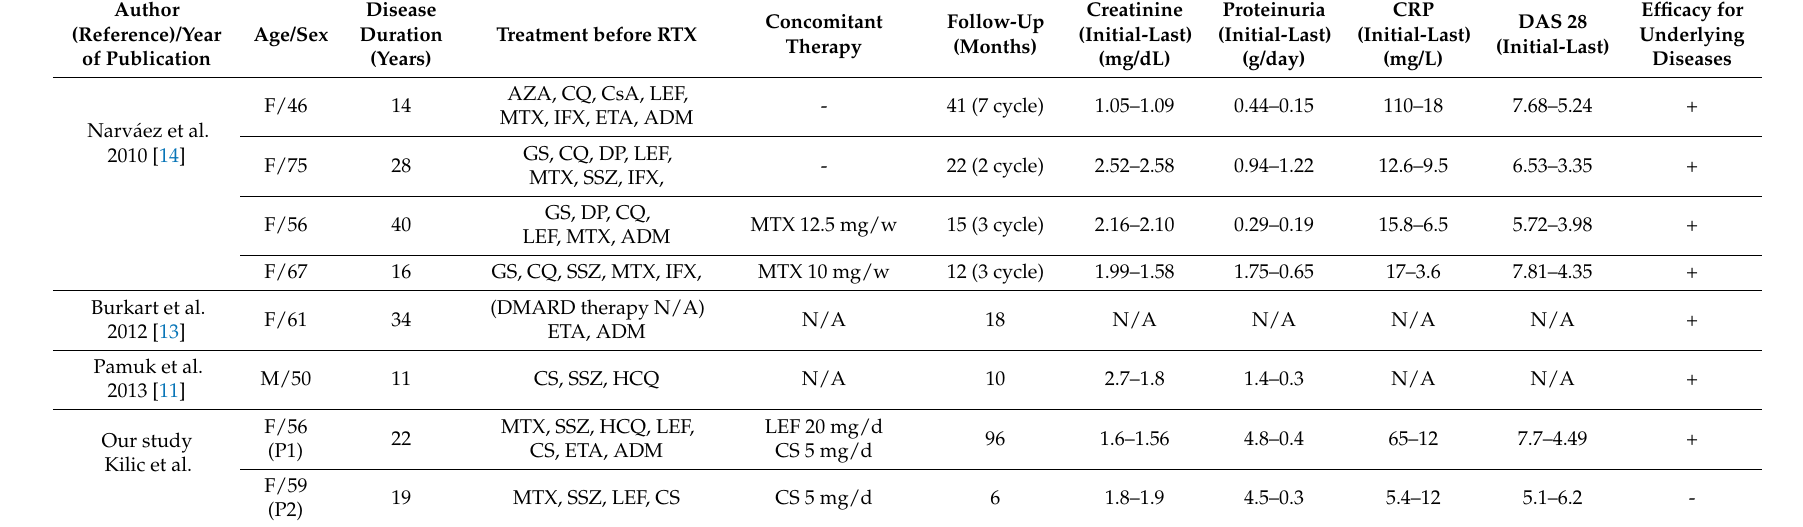
Table 2. Efficacy of rituximab therapy in RA and AA amyloidosis: Briefly; A review of the